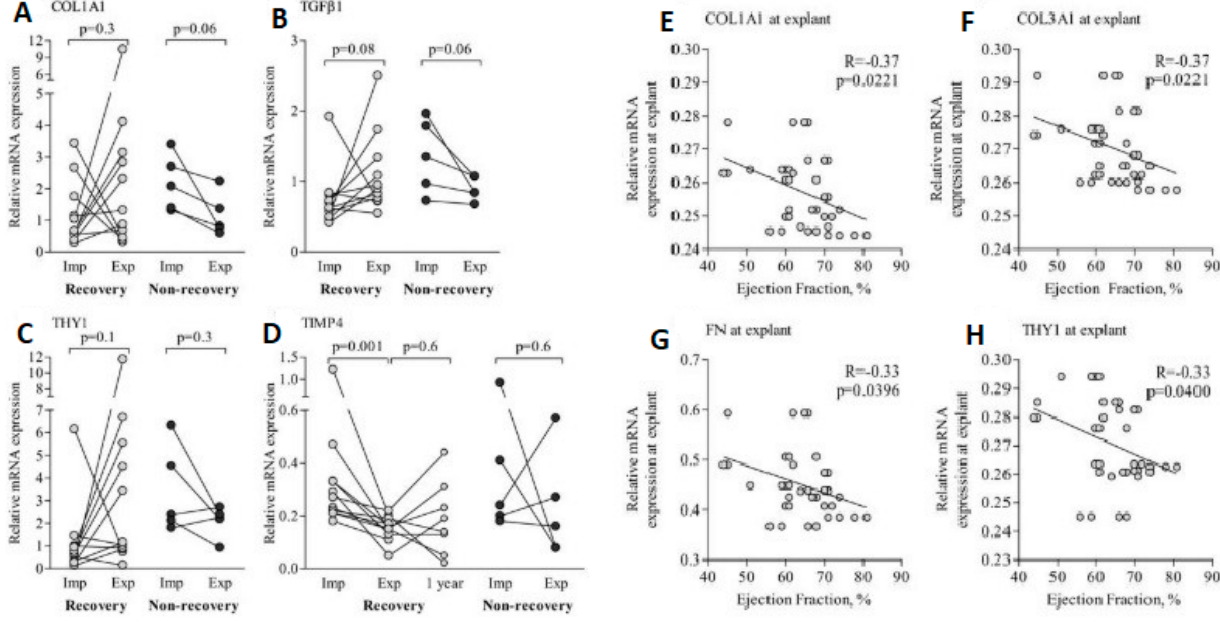
Figure 2. ( A , B ): The changes in the mRNAs of COLIAN1, TGF1 β , in which no statistical difference is observed before and after the removal of the LVAD. ( C , D ): The changes in the mRNAs of THY1 and TIMP4, where there is a statistically significant difference between the patients who recovered and those who did not. ( E – H ): mRNA expression of COL1A1, COL3A1, FN and THY1 after LVAD removal was negatively correlated with ejection fraction. Reprinted with permission from Felkin LE, et al., (2009), Copyright © 2009 International Society for Heart and Lung Transplantation. Published by Elsevier Inc. Ref. [19].